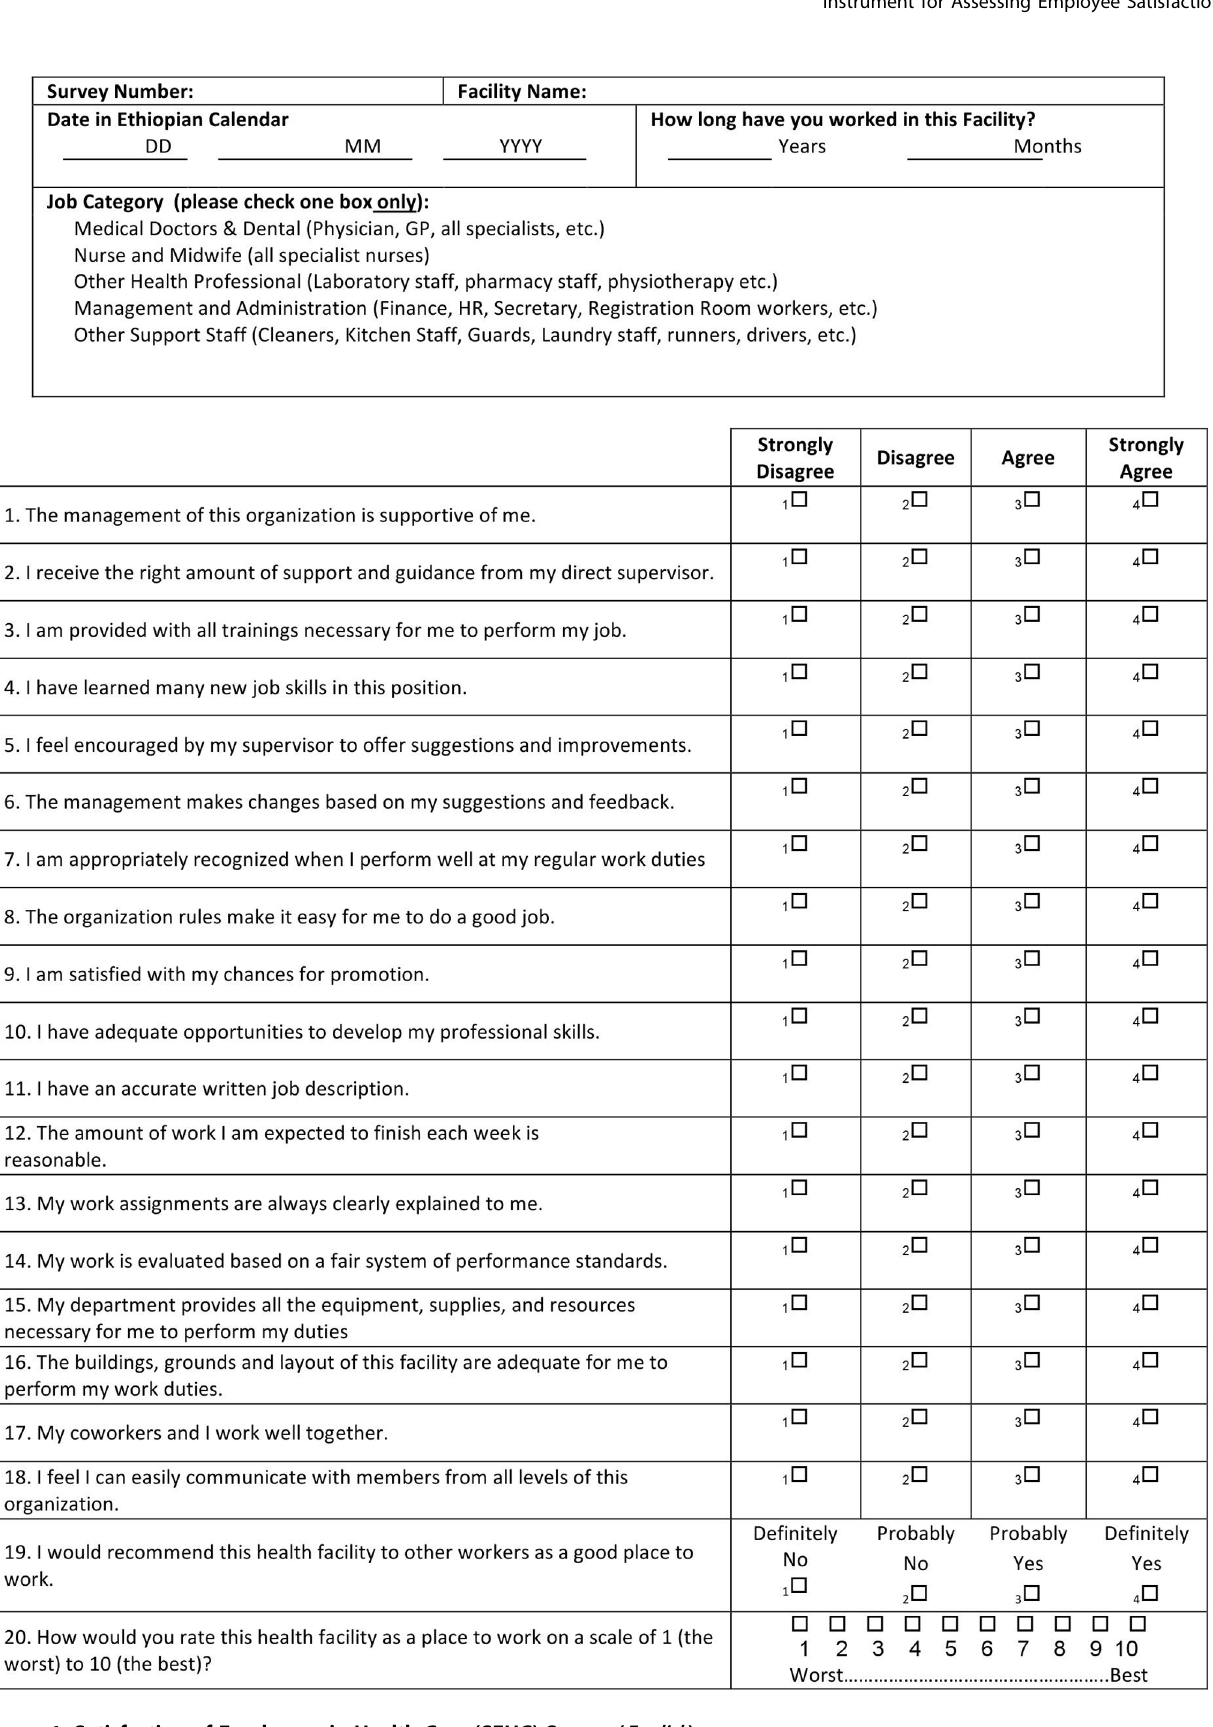
Figure 1. Satisfaction of Employees in Health Care (SEHC) Survey ( English ). doi:10.1371/journal.pone.0079053.g001 PLOS ONE |